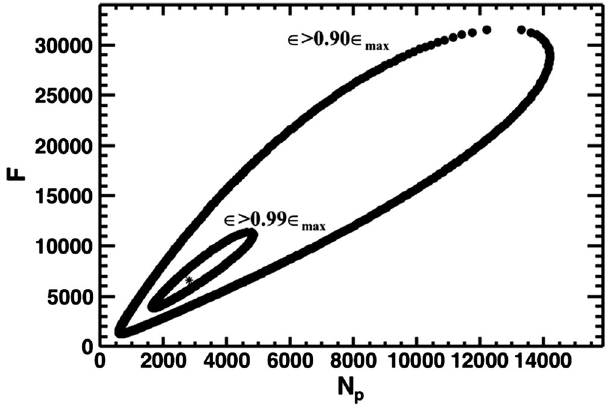
FIG. 2. Optimum values for F and N p and contour plots delimiting areas where ϵ > 0 . 90 ϵ N 250 . e ¼